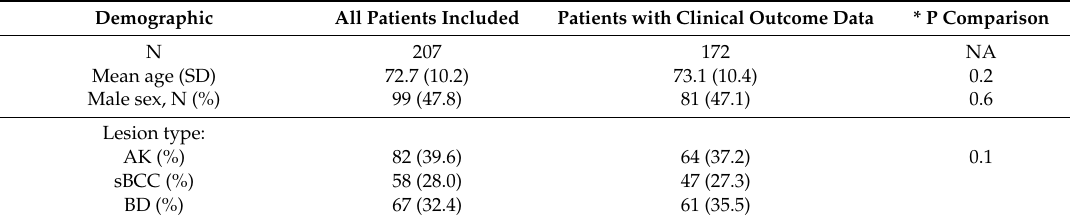
Table 1. Demographic comparison of the participants with complete PpIX fluorescence data sets either with or without clinical outcome data